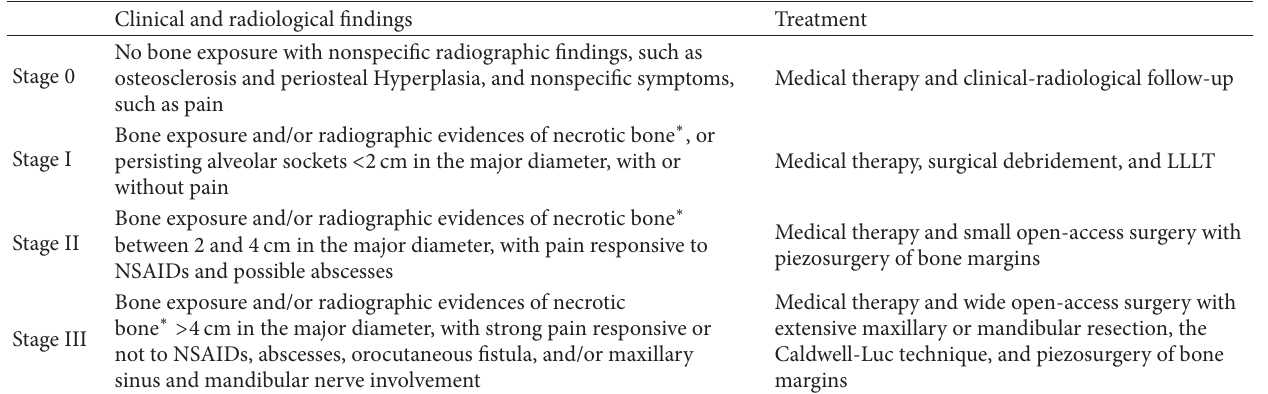
Table 2: Dimensional